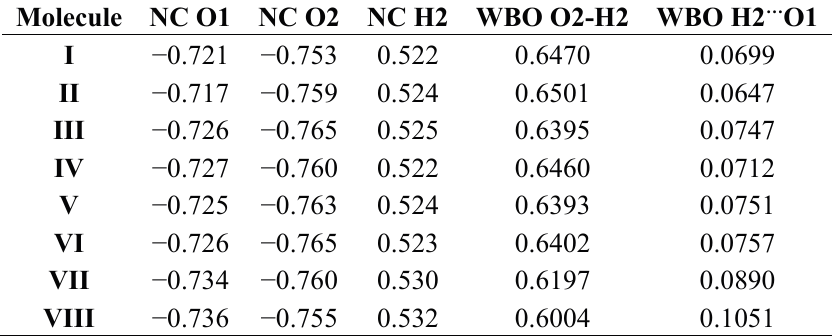
Table 3. Natural charges (NC) and Wiberg bond order (WBO) at HF/6-311G** //B3LYP/6-31++G** level for selected atoms in